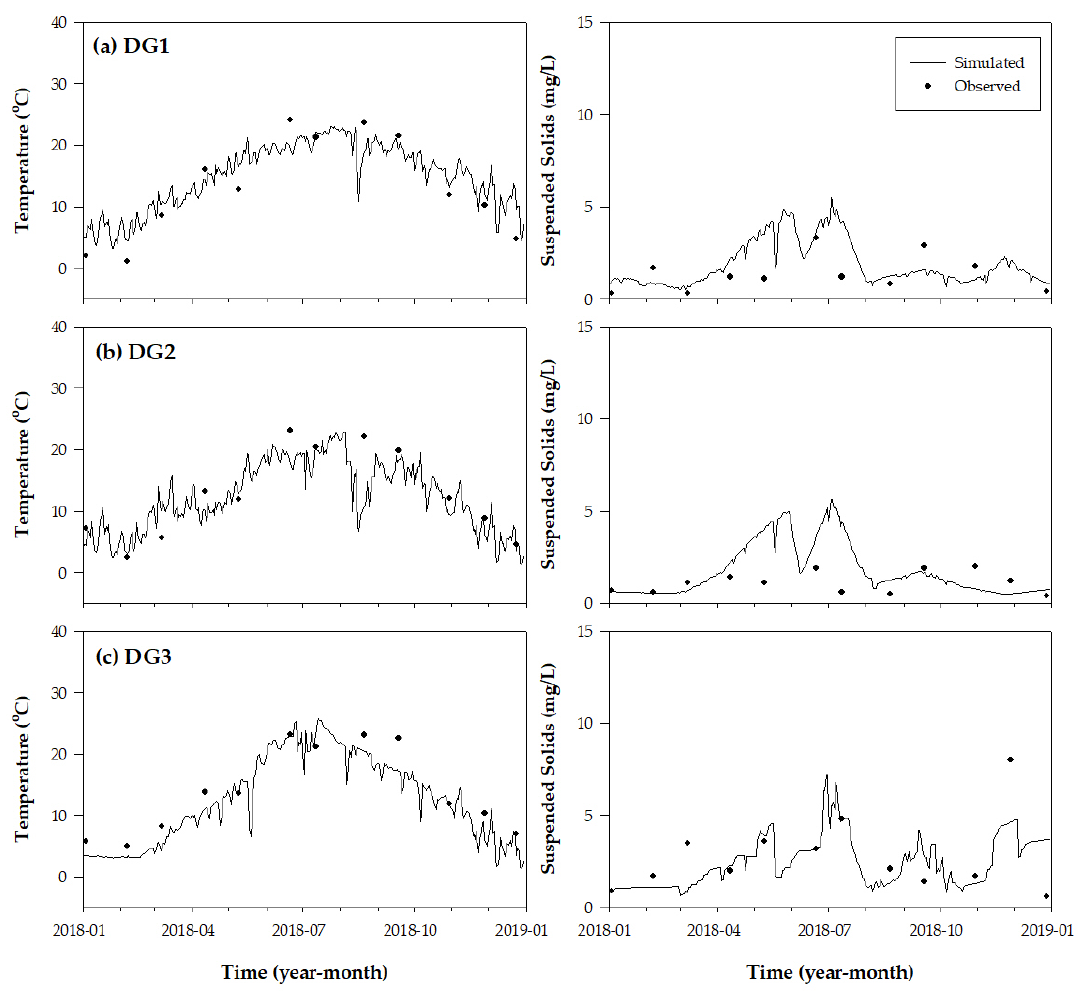
Figure 4. Results of the EFDC model validation for the temperature and SS concentration in Kangnung Namdae Stream at ( a ) DG1, ( b ) DG2, and ( c ) DG3.